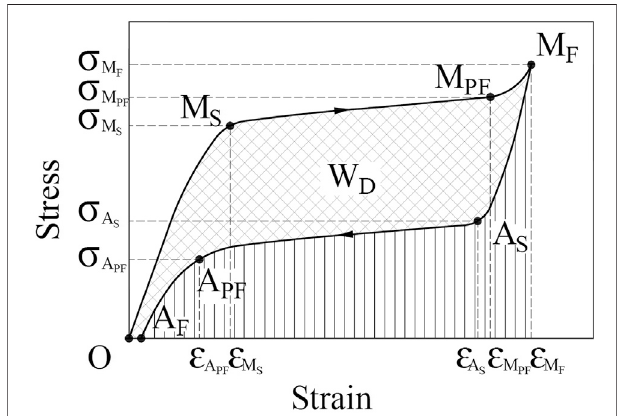
FIGURE 1 | Typical hysteretic stress-strain curve of SMA wires.